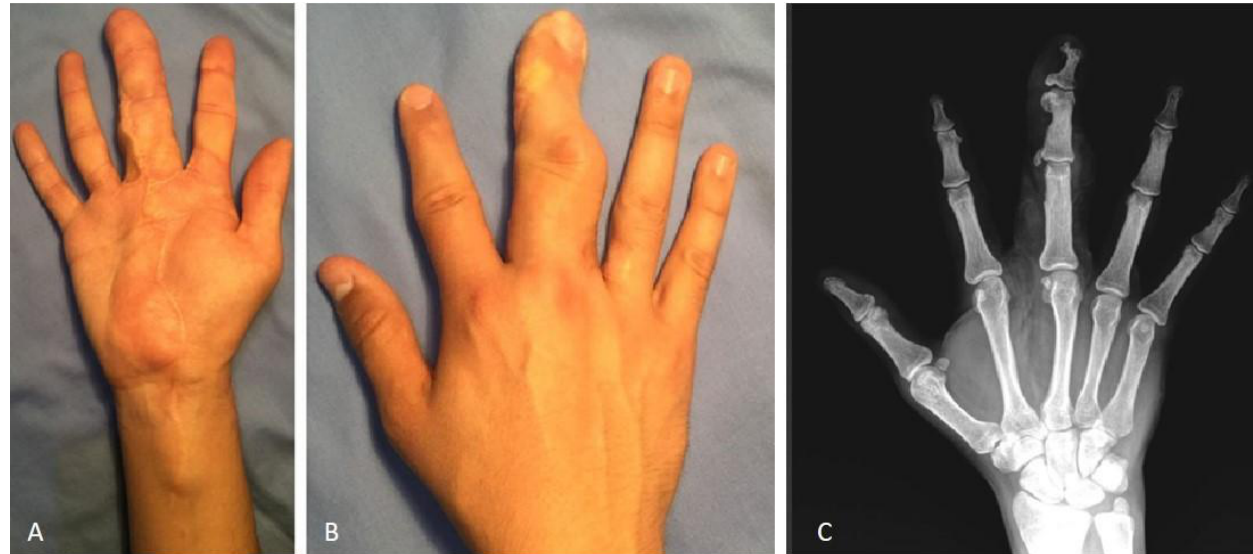
Figure 1: Lipofibromatous hamartoma of the median nerve, volar (A) and dorsal (B) aspect of the right hand. A Z-plasty and skin autograft in the proximal third of the ulnar face of the third finger is seen. Note the separation between the third and second metacarpal with an increase in volume. (C) Anteroposterior x-ray of the right hand. Exostoses are seen in the phalanges of the middle and index fingers. There is gigantism of the middle finger with increased distance between the second and third metacarpal (fourth collateral branch of the median nerve that infiltrates the second lumbrical